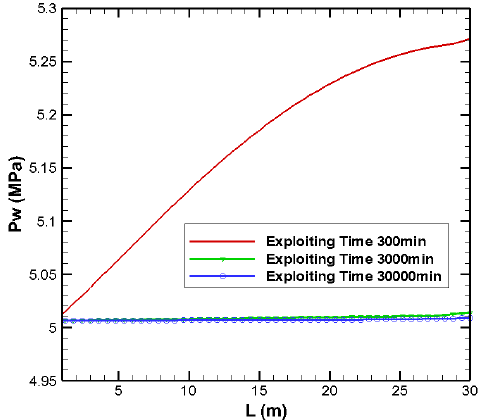
Figure 4. Comparison of pressure distribution in the reservoir under well pressure of 5 MPa and initial temperature of 284 K at different exploiting times (300 min, 3000 min, and 30,000 min).